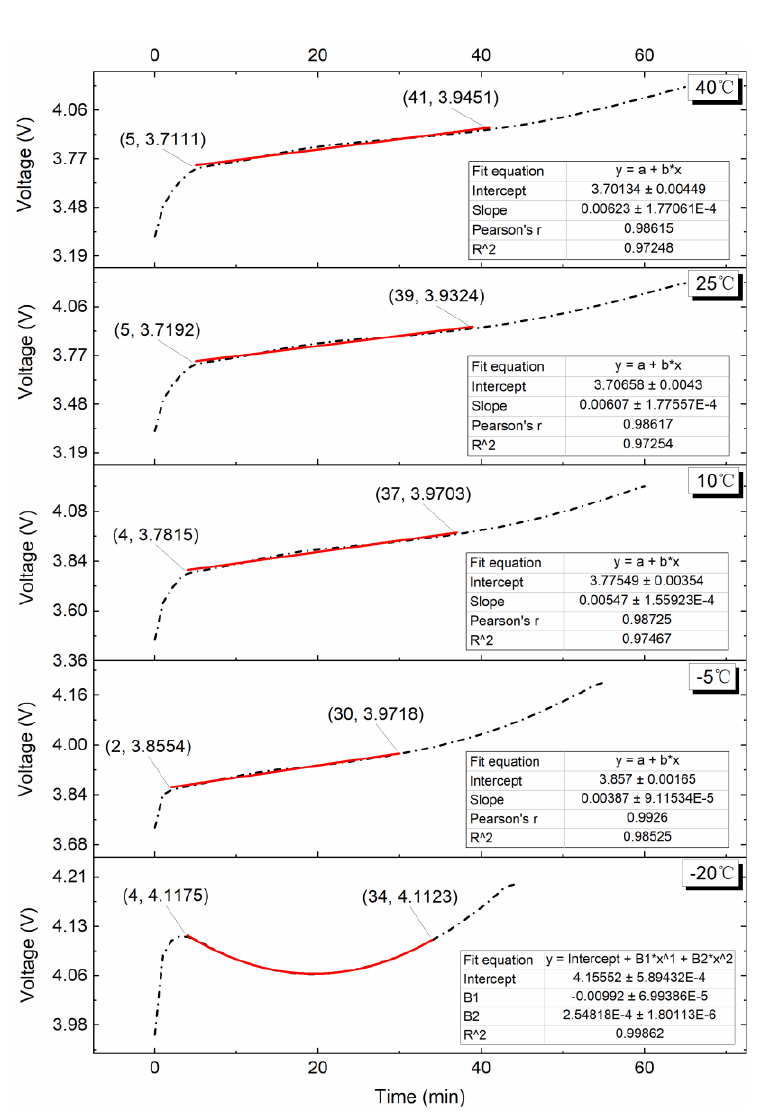
Figure 13. Effect of various temperatures on the VPP at 0.75C charging.